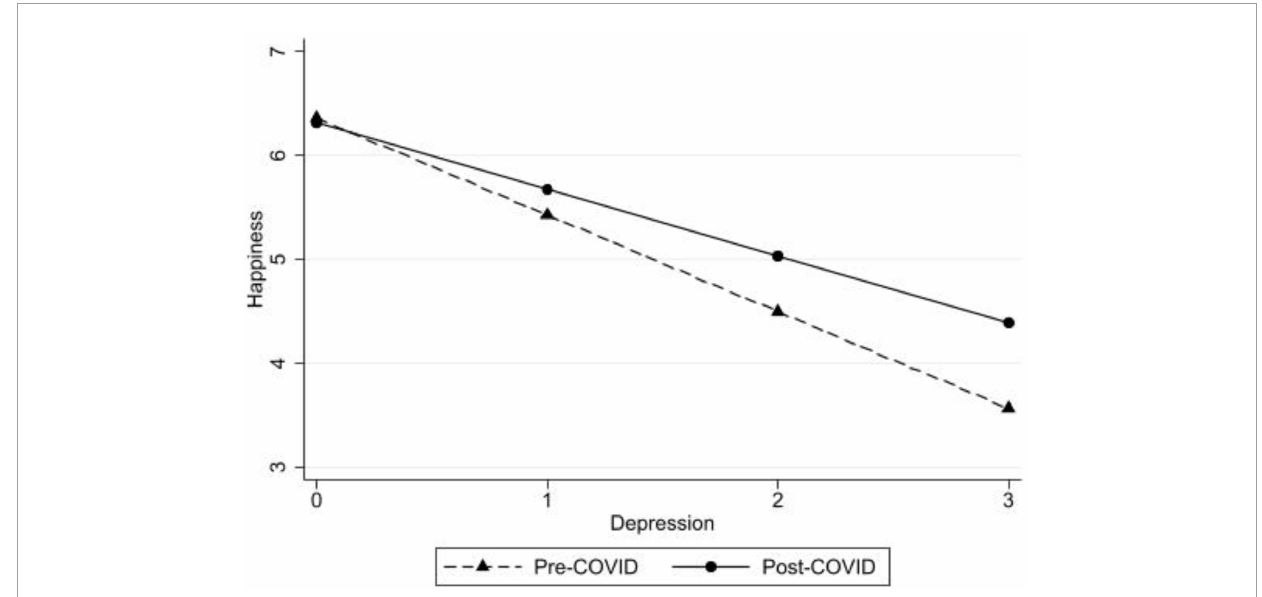
FIGURE1 Depression symptoms predicting happiness pre- and post- the COVID-19 pandemic declaration with the full sample.